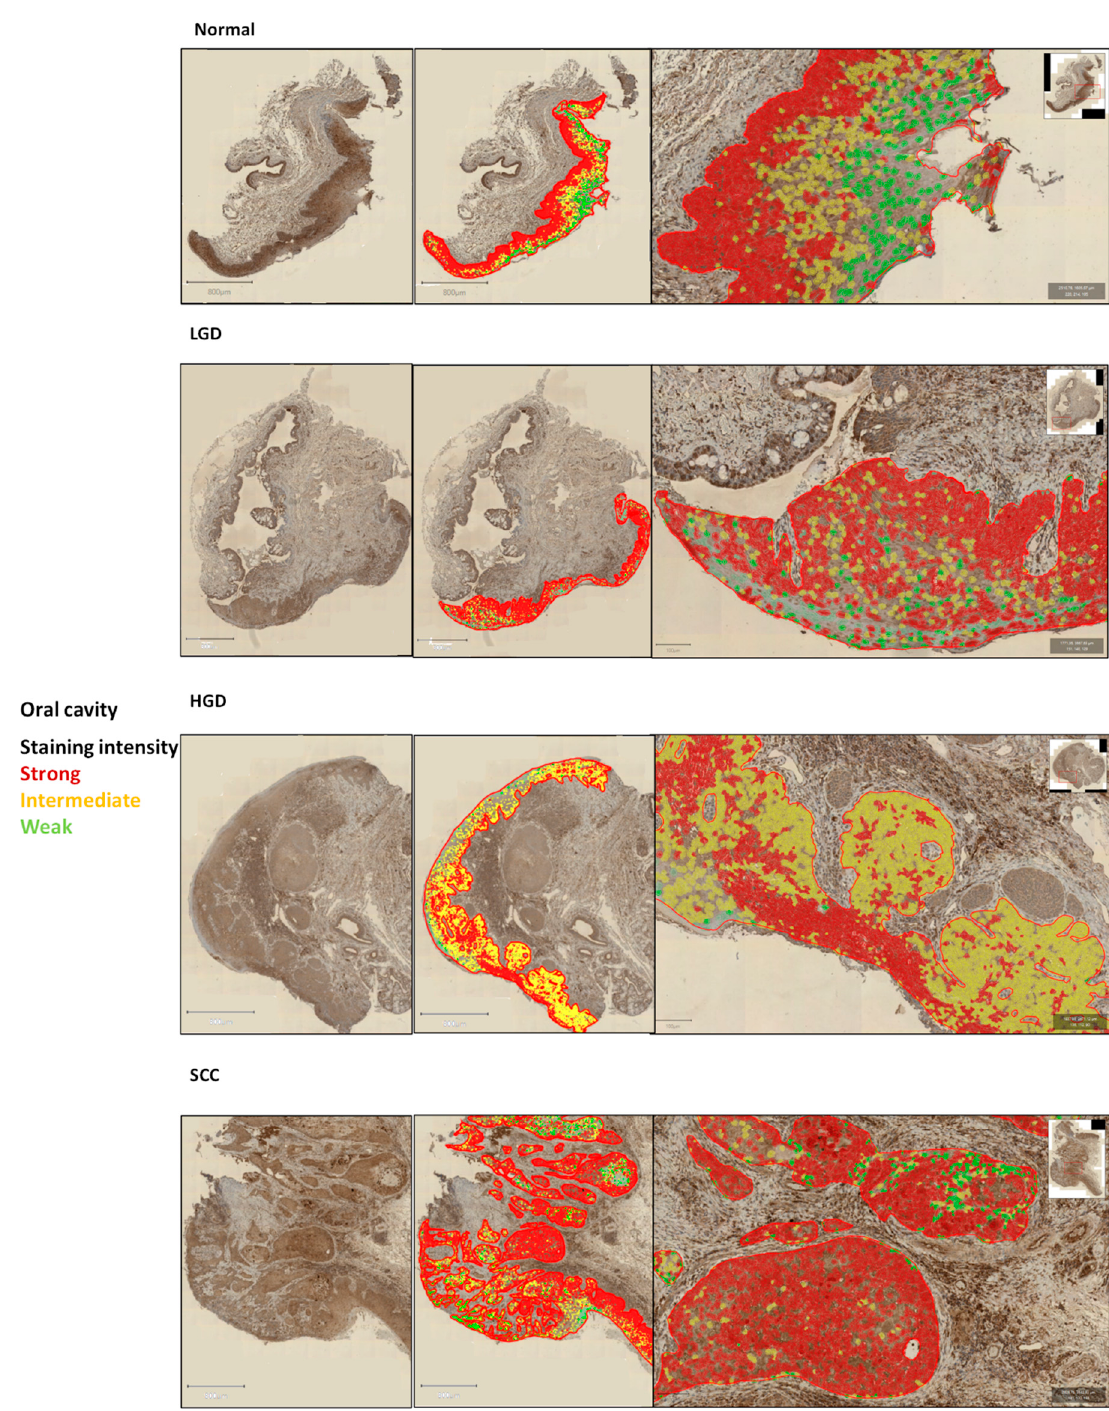
Figure 1. Representative sections from whole-slide scans (X20) of normal, low-grade dysplasia (LGD), high-grade dysplasia (HGD), and squamous cell carcinoma (SCC) from the floor of the mouth. The left panel shows the immunohistochemical staining for sCTLA-4 (DAB, brown) counterstained with haematoxylin (blue); the scale bar represents 800 μ m. The middle panel shows the annotations and cell detections with colour-coded staining intensities for the same sections. The right panel represents zoomed-in views of the cell detection, with the scale bar representing 100 μ m and the inset showing the exact site of the magnified view.